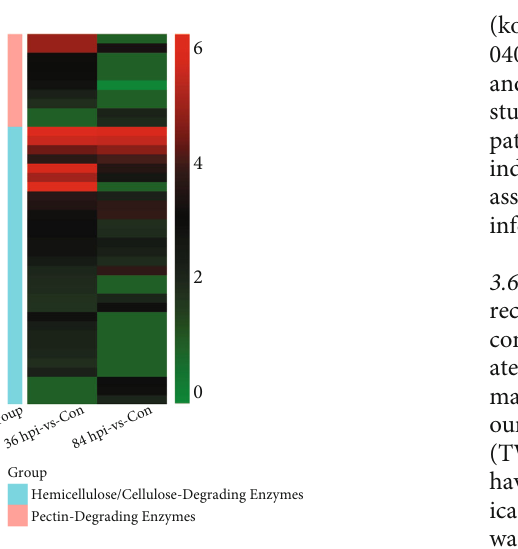
Figure 7: A heatmap of di ff erentially expressed genes associated with CWDEs. Each small square represents a CWDE-associated DEG, and the color represents the log2 fold change of gene di ff erential expression. Red indicates genes with high expression levels in 36/84 hpi-vs-Con. Green indicates genes with low expression levels in 36/84